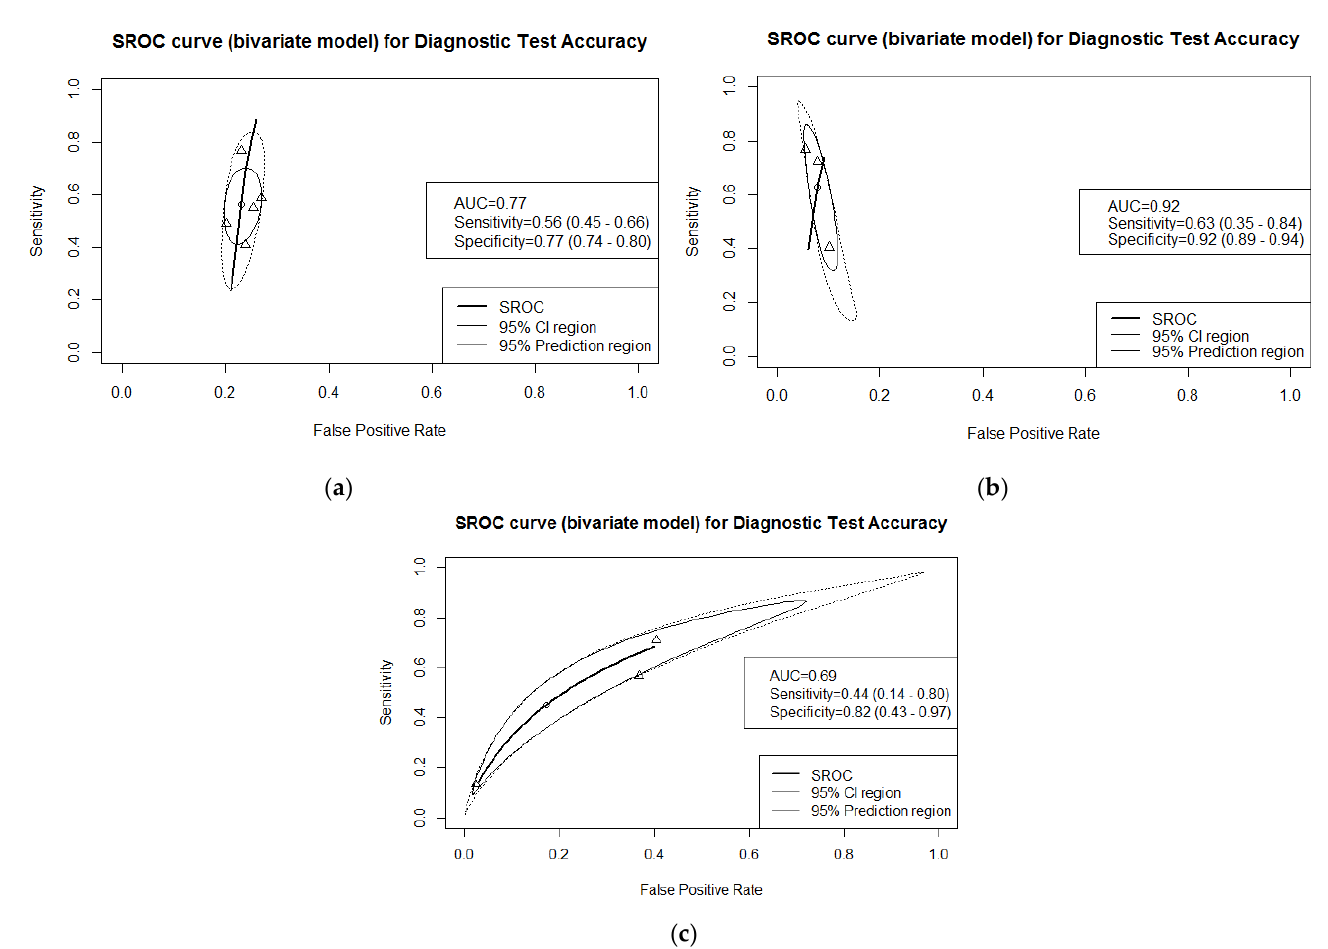
Figure 4. SROC curves for FibroTest in detecting significant fibrosis ( a ), cirrhosis ( b ), and any fibrosis level ( c ). In each plot, the circle (summary point) represents the summary estimate of sensitivity and specificity. Each triangle represents a single threshold value reported from an included study. The solid eclipse represents the 95% confidence region, and the dotted eclipse represents the prediction region. AUC: area under the receiver operating curve, 50%.